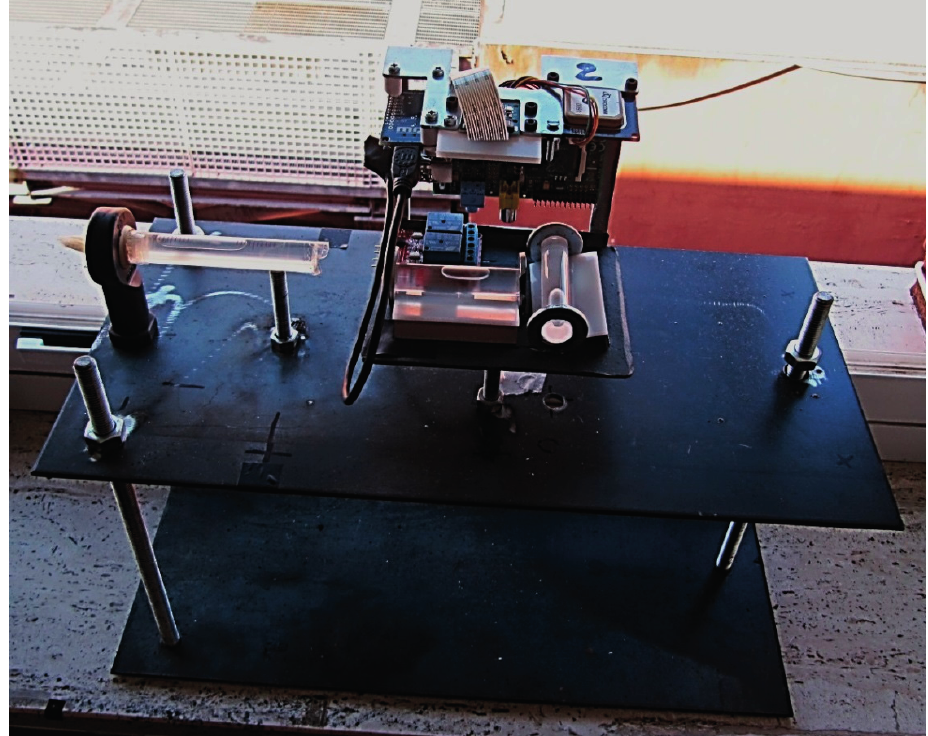
Figure 10. The spirit level